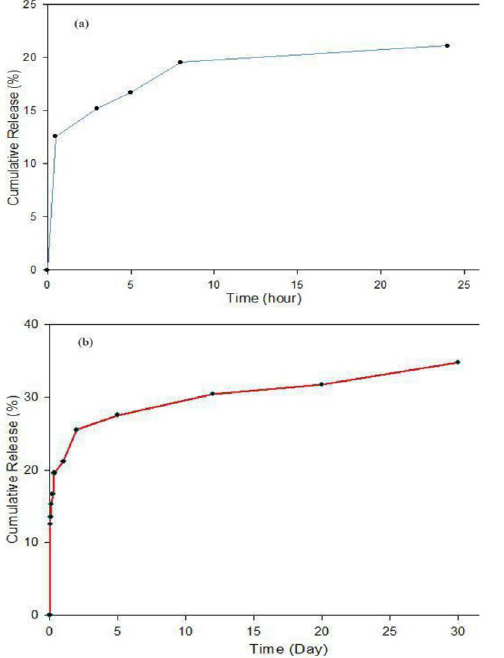
Fig. 5. Drug release profile of Cur-PCL nanofibers for A) 24 hours, B) 30 days